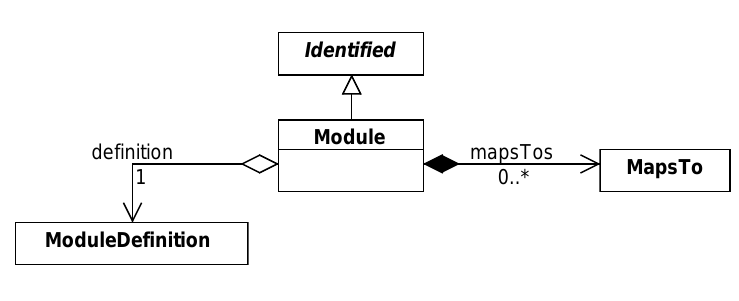
Figure 16: Diagram of the Module class and its associated